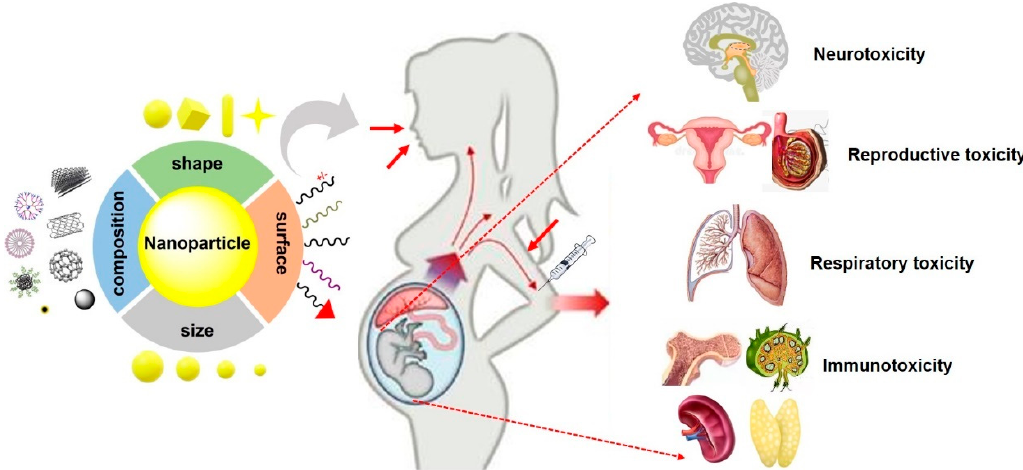
Figure 2. Typical fetotoxicity potentially induced by various NPs. The properties of NPs such as size, shape, composition and surface chemistry are key parameters that affect fetotoxicity following maternal exposure NPs during pregnancy. In addition, maternal conditions and exposure routes, also play crucial roles in NP-induced fetotoxicity.